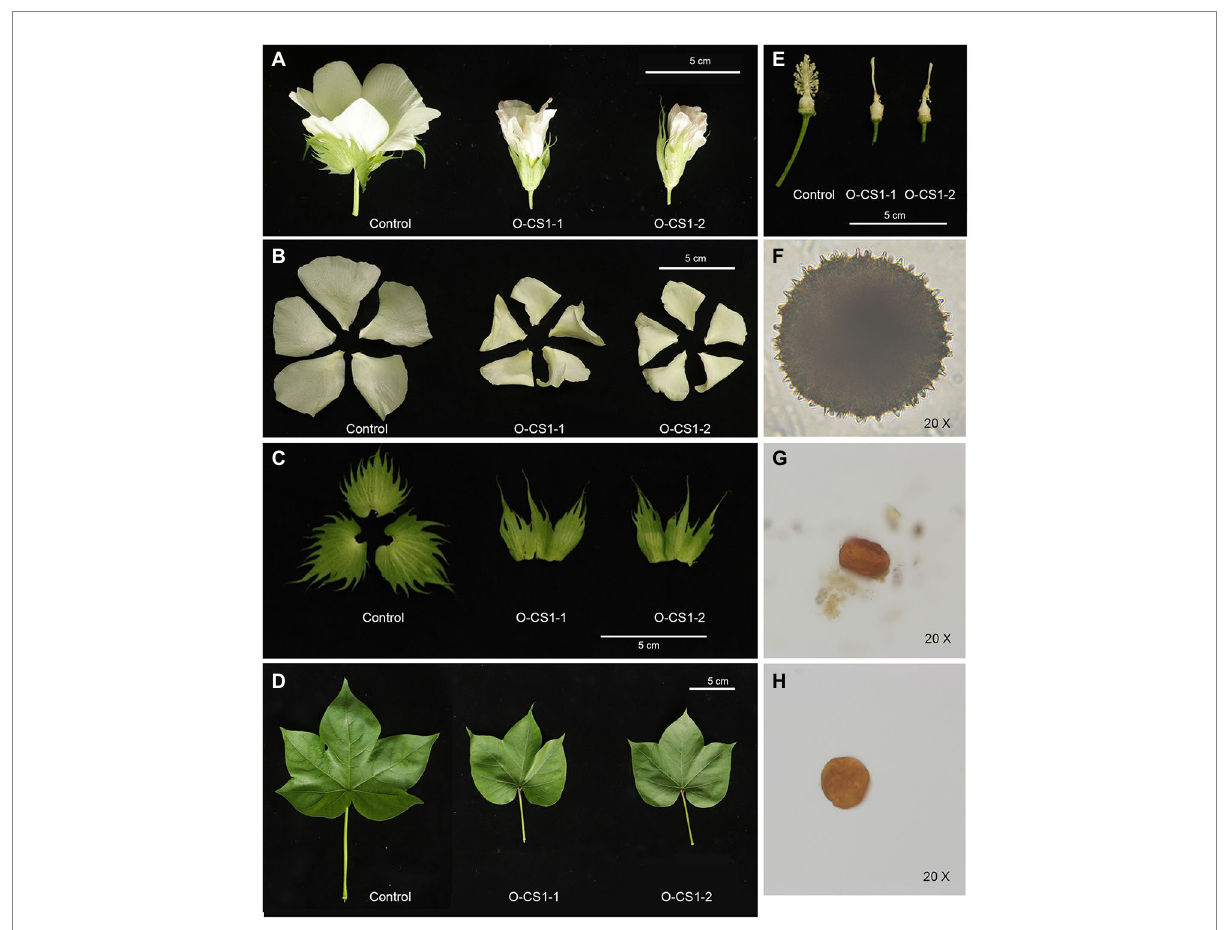
FIGURE 4 Phenotypes of GhCS1 -overexpression lines. (A) The 0-DPA flowers from transgenic cotton plant and control plant. (B) The petals of transgenic cotton plant and control plant. (C) The sepals from transgenic cotton plant and control plant. (D) The leaves from transgenic cotton plant and control plant. (E) The stamen and pistil of control plant and transgenic cotton plants. (F) Control plant pollen. (G) The pollen of O-CS1-1. (H) The pollen of O-CS1-2. O-CS1-1 and O-CS1-2: Overexpressing GhCS1 transgenic cotton lines 1# and